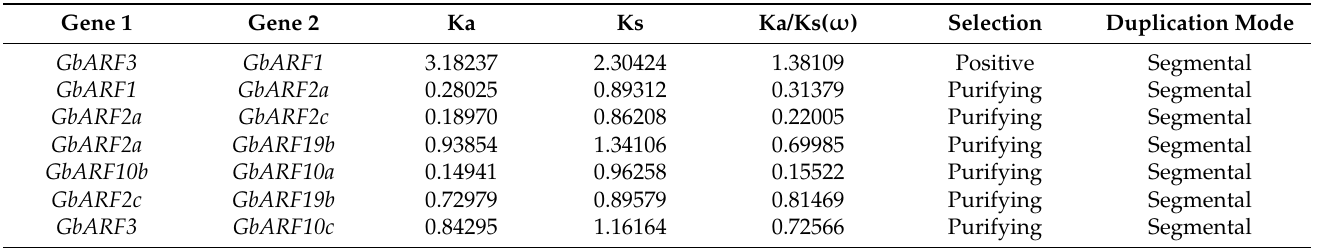
Table 2. Ka (nonsynonymous), Ks(synonymous), and Ka/Ks ratio of duplicated GbARF genes. Gene